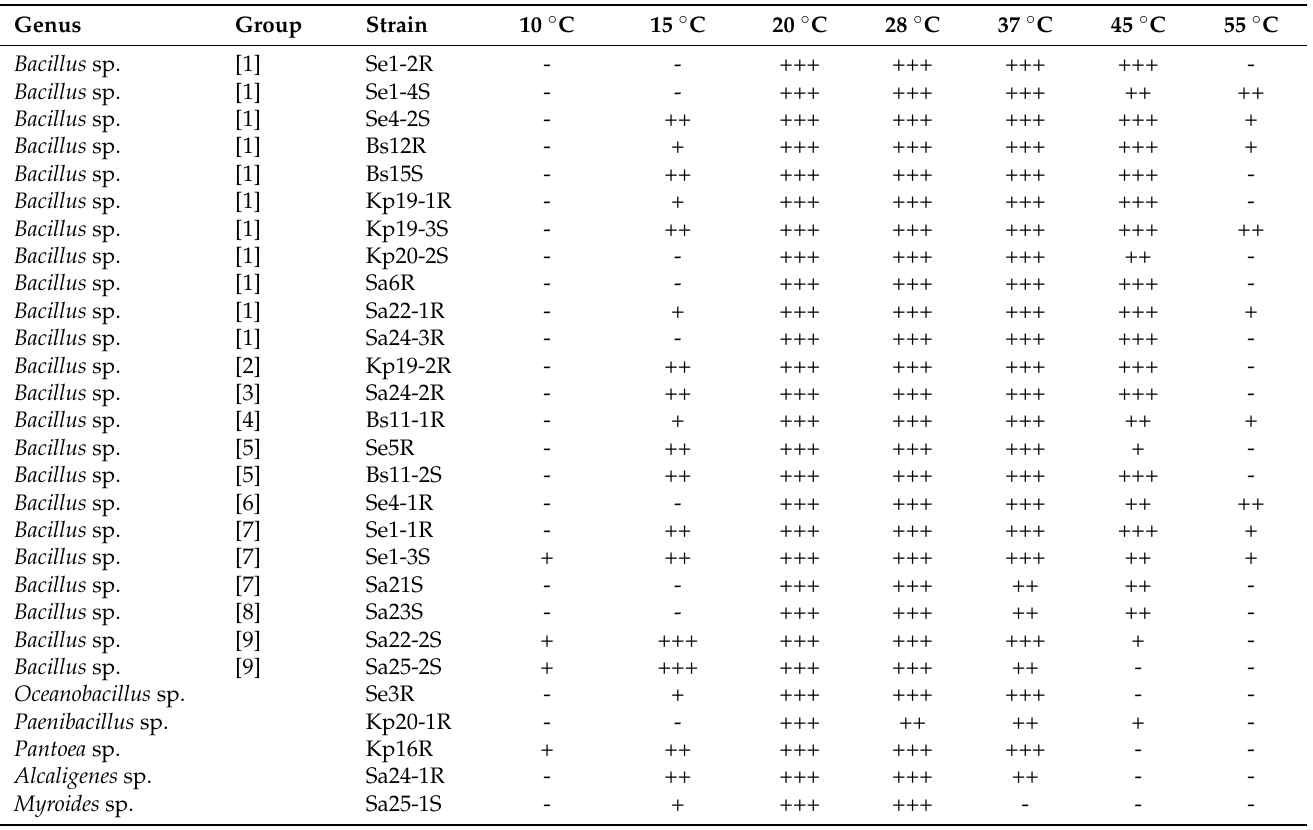
Table 3. The Effect of Temperature on the Growth of